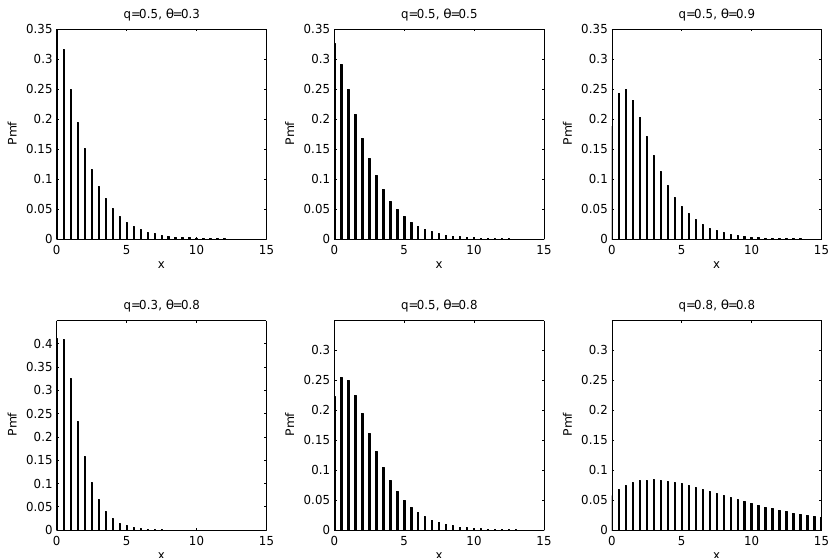
Figure 1. Plots of the pmf of the TRTG distribution for some choices of q and θ .